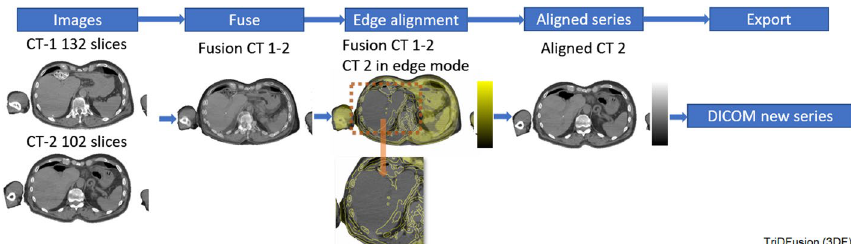
Fig. 11 Image edge detection workflow for fusion of misaligned image using a constraint (orange box) of computed tomography (CT)-1 fused with CT-2 to resolve the misalignment